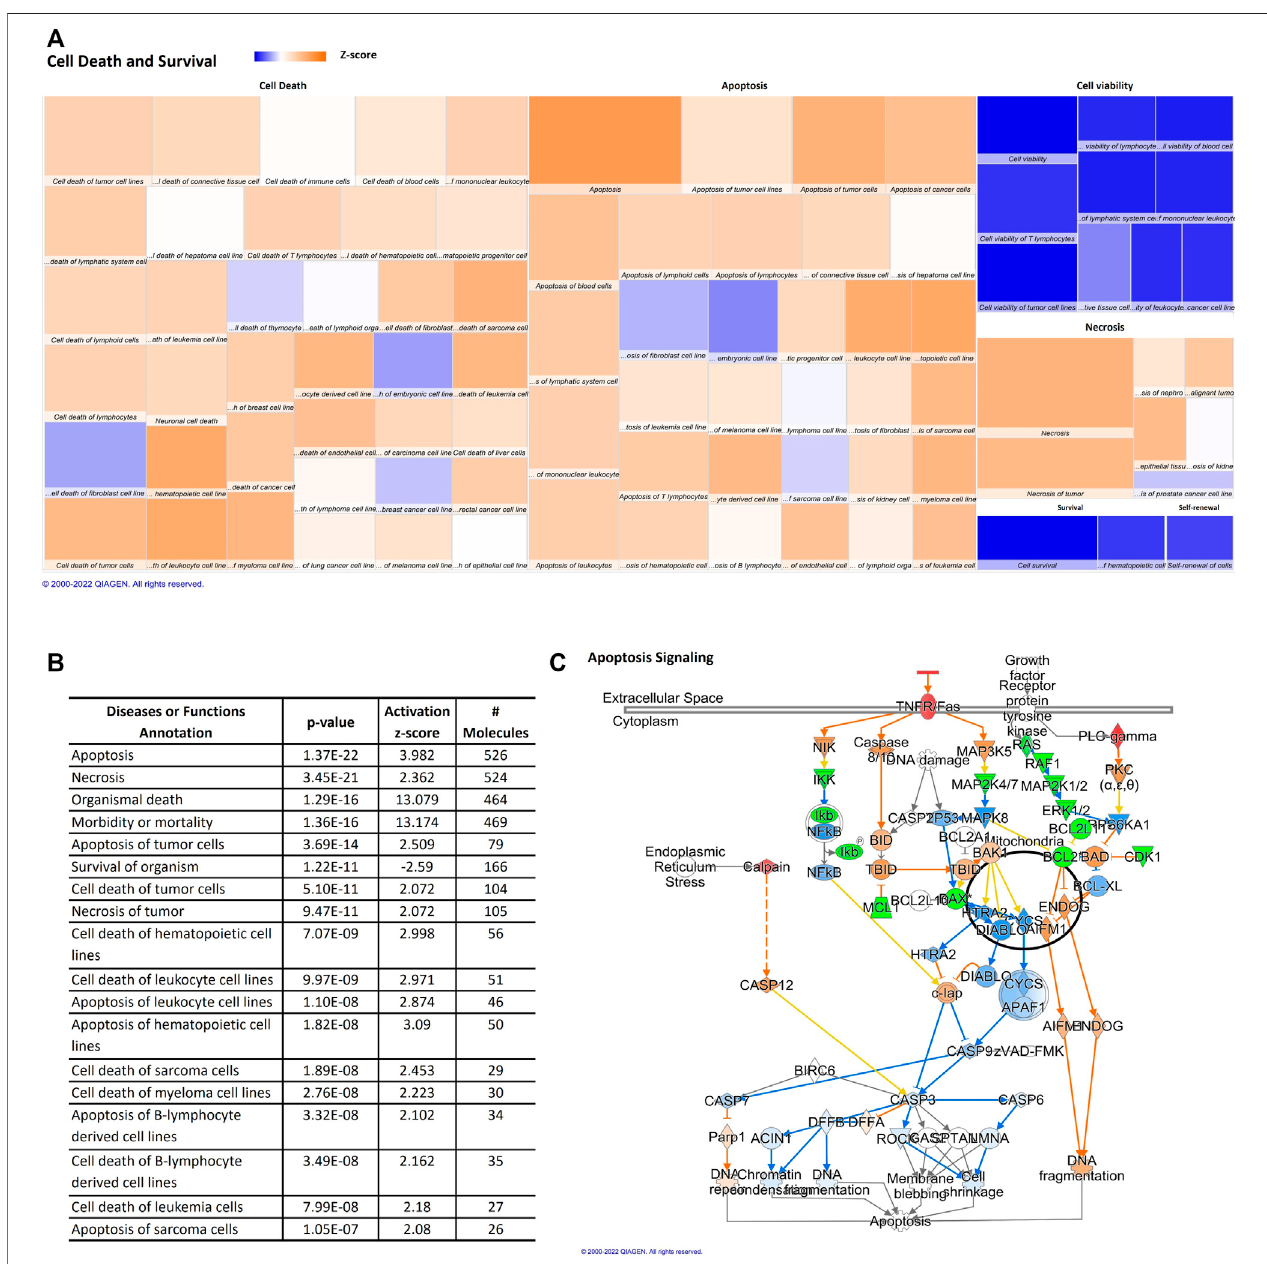
FIGURE 4 | Aging-induced predicted effects of miRNAs content in circulating adipocyte-derived EVPs on Cell Death and Survival. (A) Heat map of the “ Cell Death andSurvival, ” amongthetop “ molecularandcellularfunctions ” categories.Eachboxrepresentsonemolecularandcellularfunction,itssizerepresentsgeneenrichment. Theheatmapisaccordingtoz-scorevalues,wherethecolorindicatesthepredictedincreaseordecreasestatus;higherZ-scoreswererepresentedbyorangeindicating activation, and lower z-scores were represented by blue indicating inhibition. (B) Top Cell Death and Survival annotations; z score, number of affected molecules, and p values. (C) Apoptosis signaling canonical pathway. FAS/TNFR and CAPN8 are upregulated by miR-210-5p changes, miR-219a-5p promotes upregulation of FASLG,andmiR-24-3pcanbeabletodownregulateBCL-2,ananti-apoptoticmolecule,bringevidencethatextrinsicandintrinsicapoptoticpathwayscanberegulated by adipocyte-derived EVPs miRNAs in aging